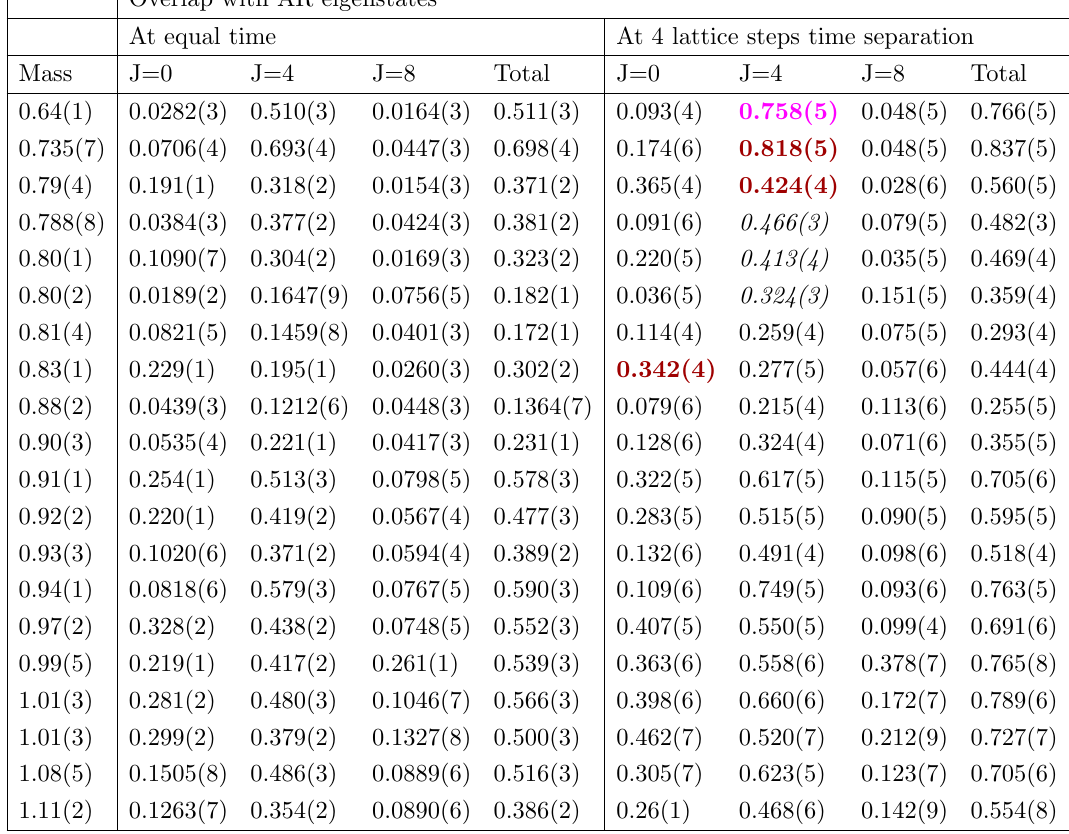
Table 13. Masses from glueballs in A 1 , C = (cid:0) representations using conventional operators and overlaps with AR